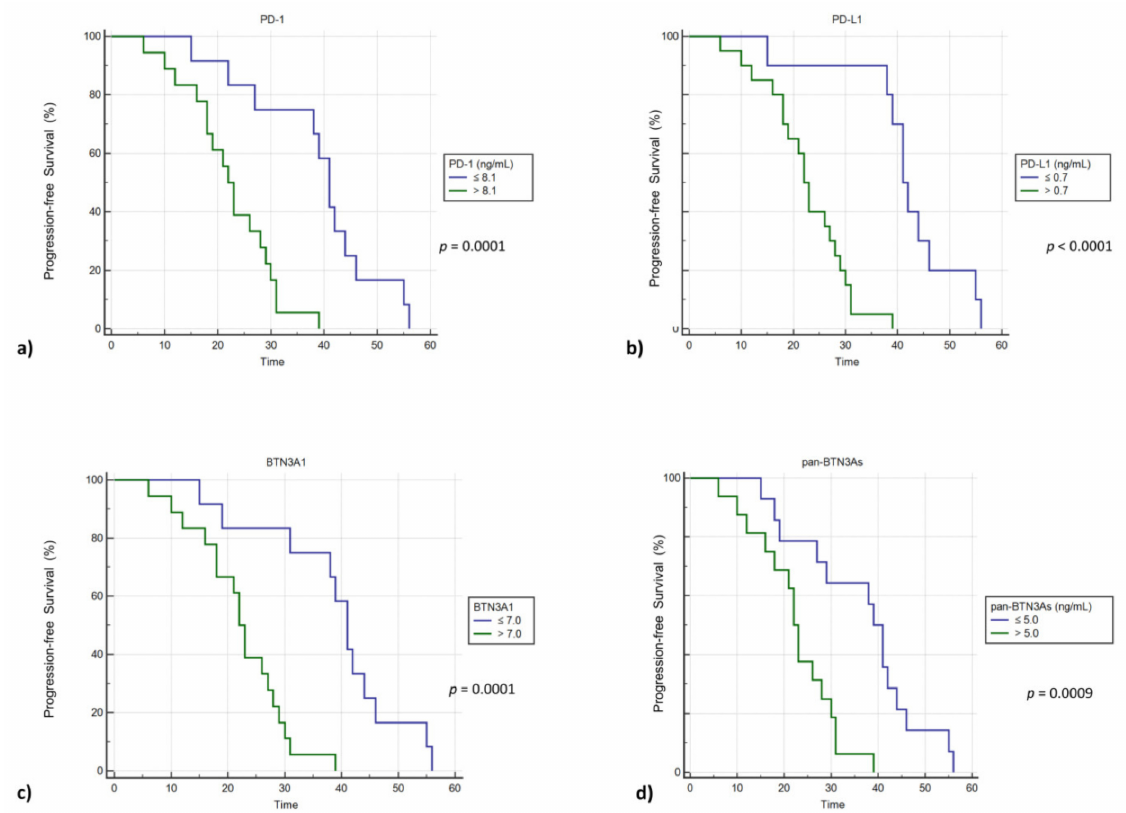
Figure 4. PFS analysis by Kaplan–Meier curves in 30 mGIST patients with baseline high and low plasma concentrations of sPD-1 ( a ), sPD-L1 ( b ), sBTN3A1 ( c ), and pan-sBTN3As ( d